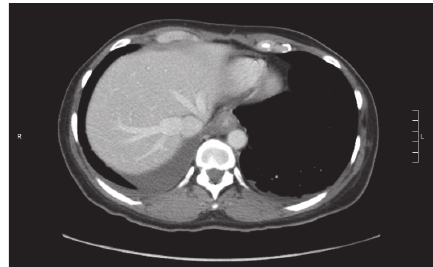
Figure 1: Abdominal CT scan revealing thickening of the distal esophagus.